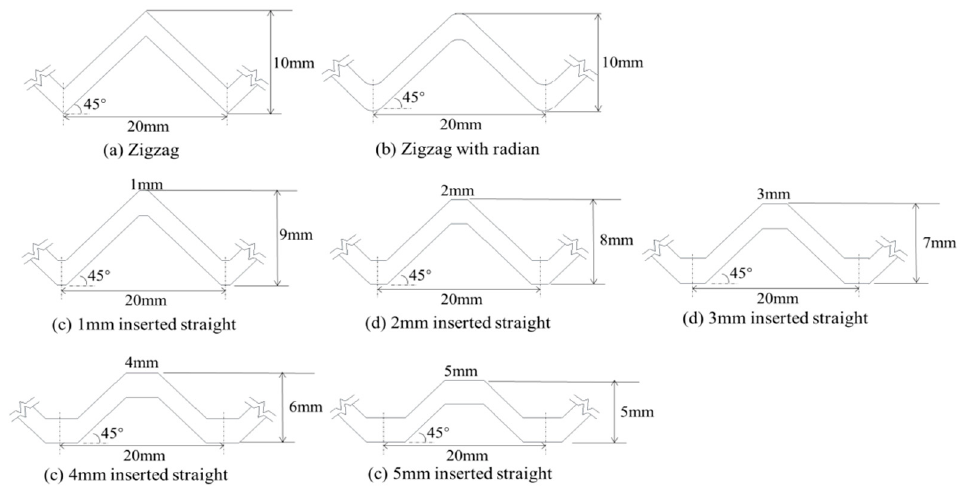
Figure 1. The simplified numerical model: ( a ) the core of PCHE; ( b ) the shape of a single channel and boundary conditions.